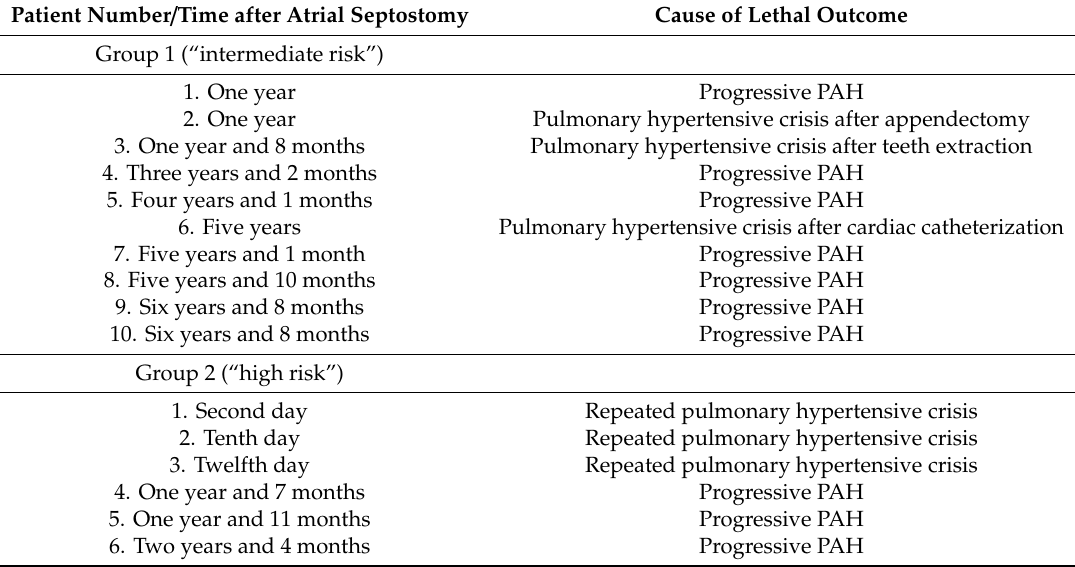
Figure 2. Kaplan–Meier survival and freedom from lung transplantation or Potts shunt curve. Patients from the “intermediate” risk group (Group 1) demonstrate significantly higher survival rate/freedom from lung transplantation or Potts shunt than patients from the “high” risk group (Group 2) ( p = 0.002). Table 3. Causes of lethal outcomes after atrial